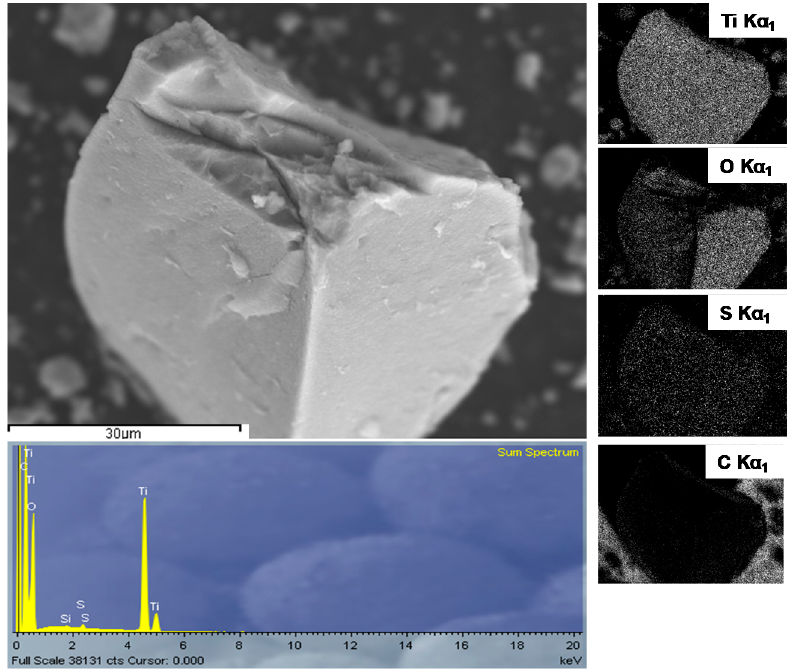
Figure 4. Energy dispersive X-ray (EDX) analysis of S-TiO 2 /rGO(5.0%).